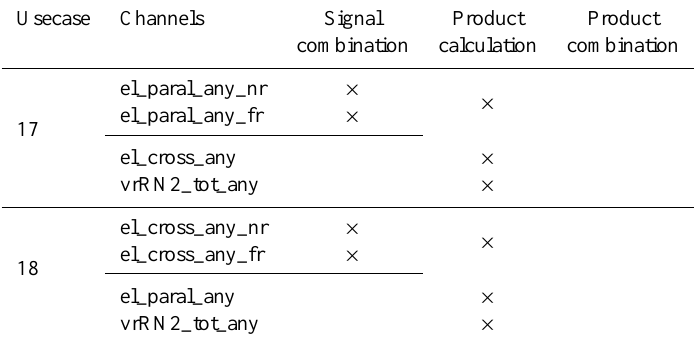
Table A2. Continued.